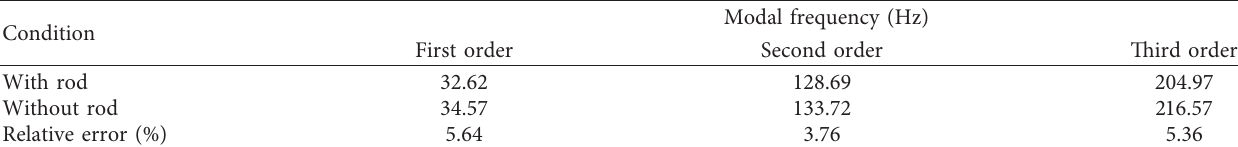
Table 8: Fist three order modal frequencies of the composite structure with/without ceramic extension rod (25 ° C). Modal frequency (Hz) Condition First order Second order Third order With rod 32.62 128.69 204.97 Without rod 34.57 133.72 216.57 Relative error